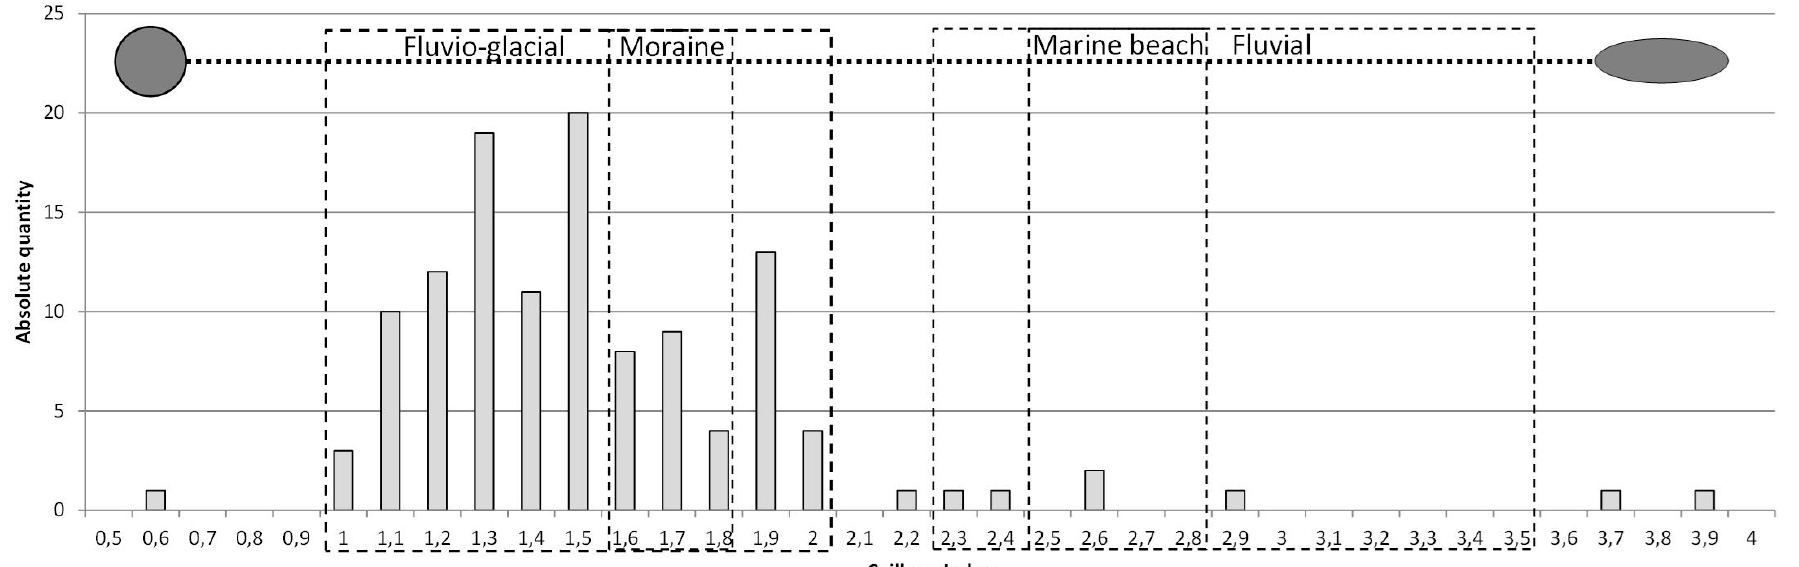
Figure 4. Absolute frequencies of the Cailleux indexes (Cailleux 1951) estimated on the basis of all unmodified pebbles recovered in the wet soil area of